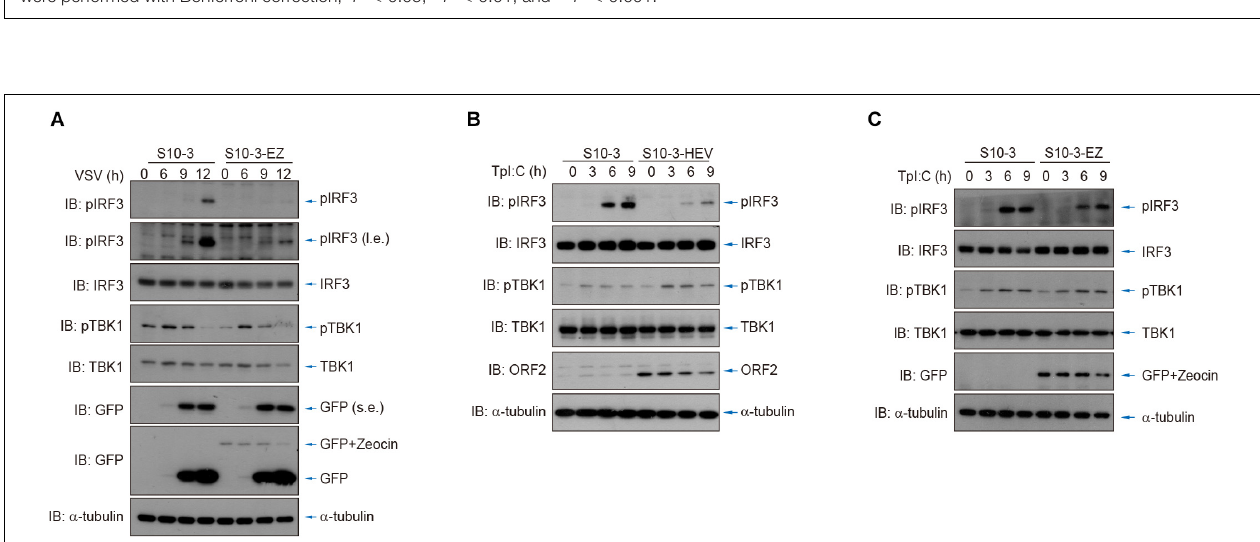
FIGURE 7 | HEV interferes with host antiviral sensing and responses after infection by VSV or transfection of poly(I:C). (A) Cytosolic RNA sensing was inhibited in S10-3-EZ compared with the parental S10-3 cells, as determined by IRF3 activation after infection by VSV. (B,C) Cytosolic RNA sensing was inhibited in HEV-infected S10-3 cells (S10-3-HEV) compared with mock-infected S10-3 cells (B) , or in persistent HEV replicon cell line S10-3-EZ compared with its parental liver cell line S10-3 (C) , which was determined by IRF3 activation after transfection of poly(I:C).